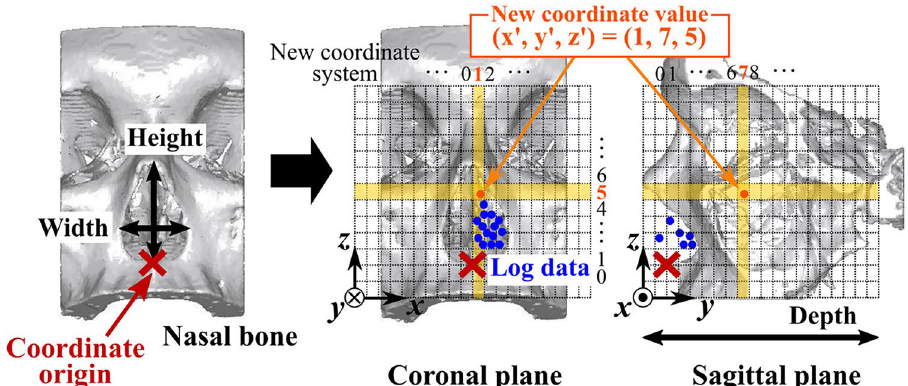
and the camera position as an element. Thus, the bimanual angle and bimanual distance 2 were added as indica- tors of the positioning of the two surgical instruments. In addition, we used the positional information of surgical instruments. At this juncture, we set a new coor- dinate system relative to the nasal anatomy, as described in a previous study 6 (Fig. 2) because the size of the nasal cavities varied among patients. We manually set the origin, axes, and scale of the new coordinate system, based on the position of the anterior nasal spine and the height, width, and depth of the nasal cavity. Then, we used the new coordinate values, P ′ i = , assigned to the surgical log data as the position information of the surgical instrument. The left and right nasal cavities were assumed to be anatomical symmetric images; thus, the new coordinate values were arranged to achieve symmetry in the nasal septum plane. The surgical process transition, described as the surgical process model (SPM), is based on the surgical motion and position data. The SPM is defined as follows: